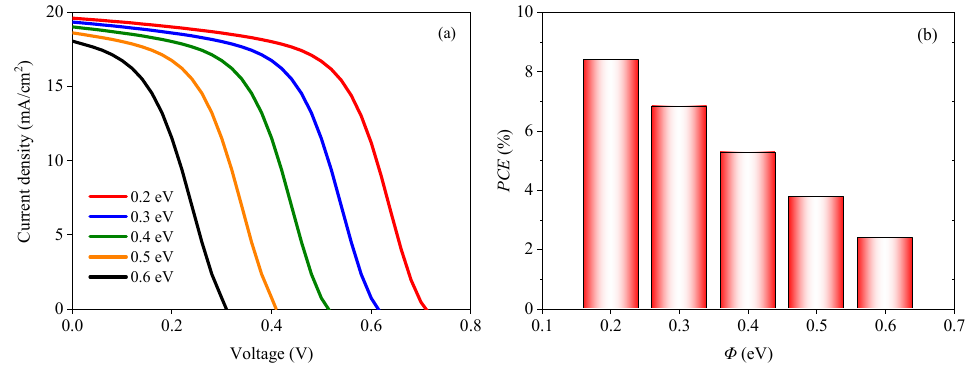
Figure 7. Effect of Φ on the solar cell: ( a ) J-V characteristic curves with different Φ values and ( b ) PCE with different Φ values.